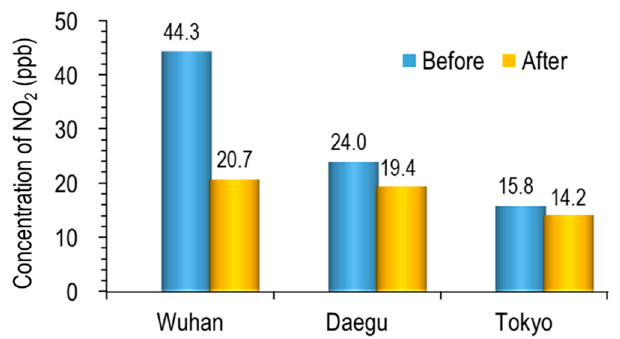
Figure 7. Comparison of NO 2 concentration before and after each city’s self-reflection.